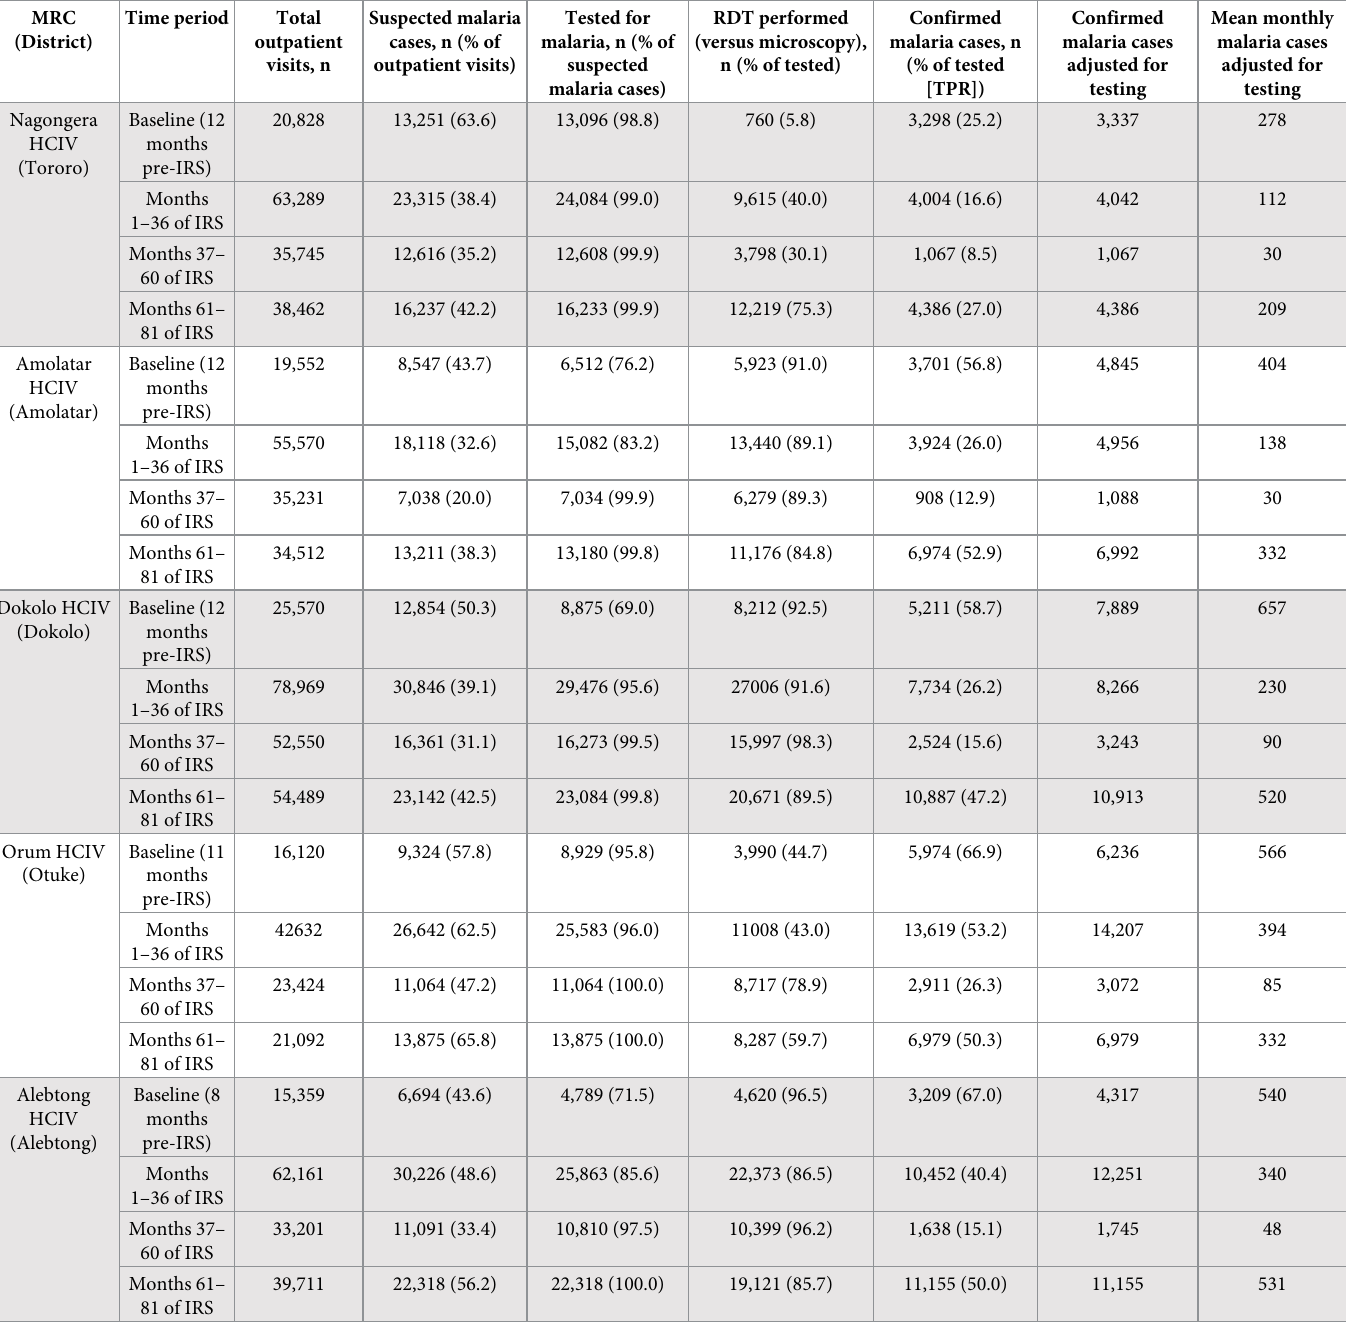
Table 1. Summary statistics from health-facility based surveillance sites for study objective